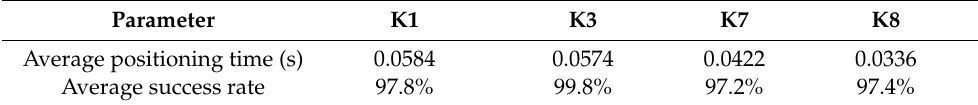
Table 17. Average positioning time and success rate for K1, K3, K7, and K8. Parameter K1 K3 K7 K8 Average positioning time (s) 0.0584 0.0574 0.0422 0.0336 Average success rate 97.8% 99.8%